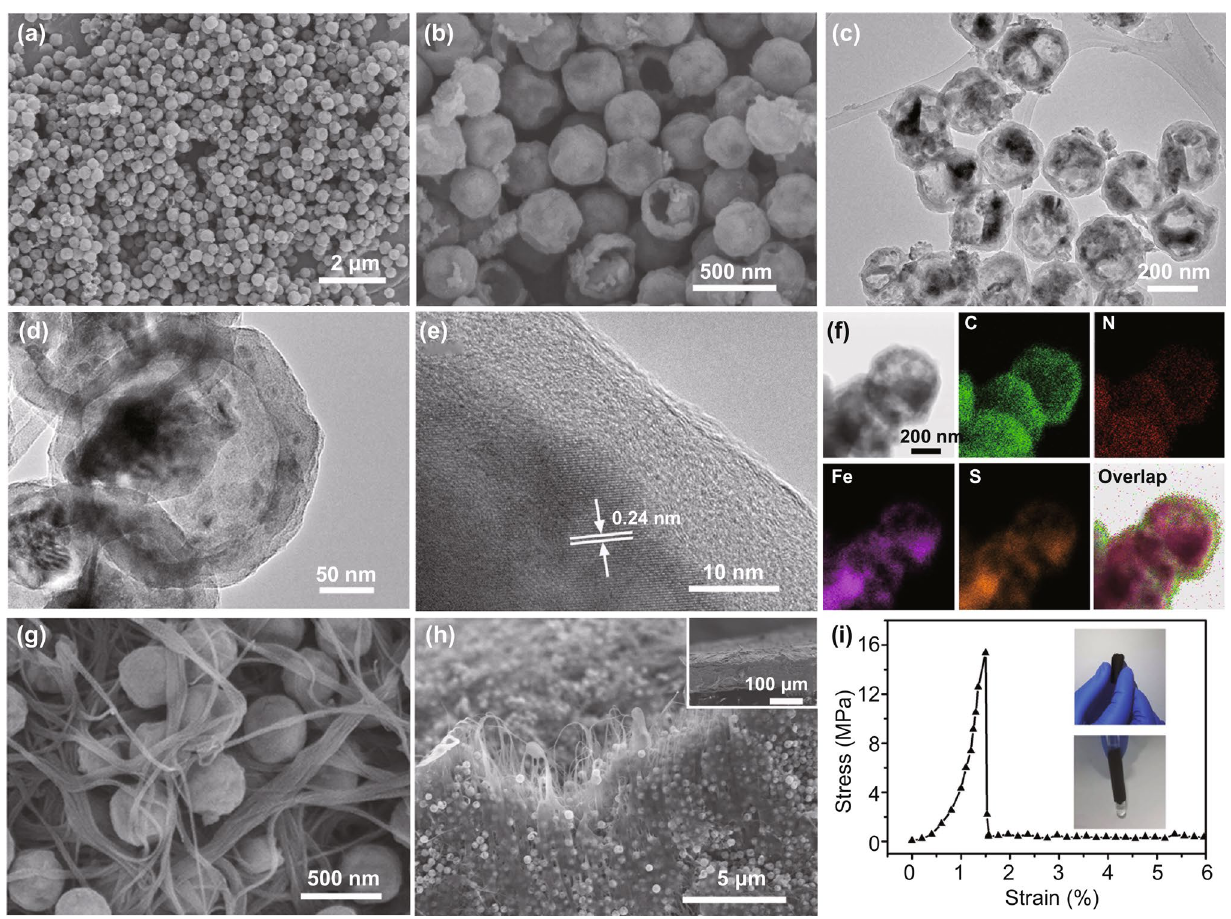
Fig. 1 SEM images of a Fe-MOF, b FeS 2 @C yolk–shell nanospheres. c, d TEM and e HR-TEM images of yolk–shell FeS 2 @C. f Element map- ping of the